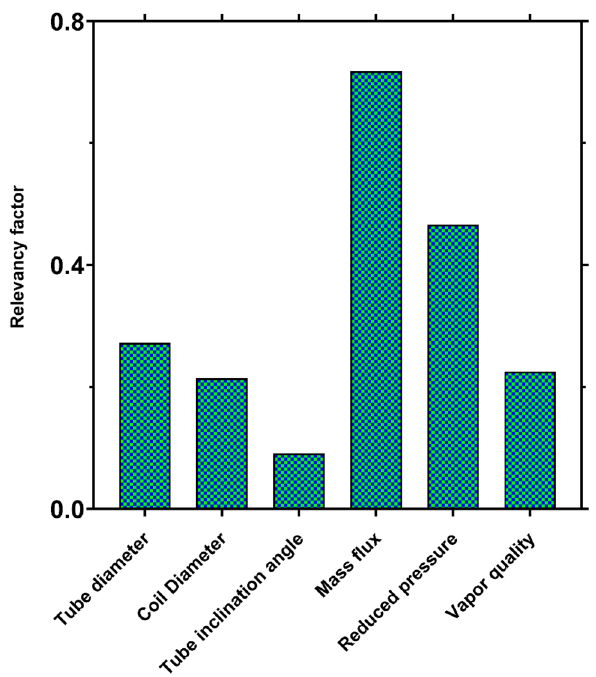
Figure 12. Comparing the importance of operating parameters in two-phase